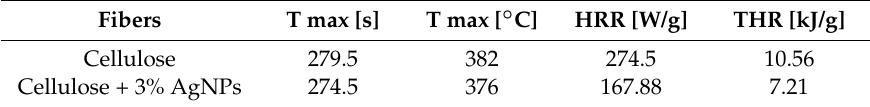
Figure 7. Results for cellulose fibers: ( a ) TG curve, ( b ) the DTG curve. The activation energy of the fiber decomposition process was determined using isoconversion linear methods, i.e., Kissinger–Akahira–Sunose (KAS) and Flynn–Wall–Ozawa (FWO) methods [34,35]. For this purpose, thermogravimetric studies of the samples were carried out at different